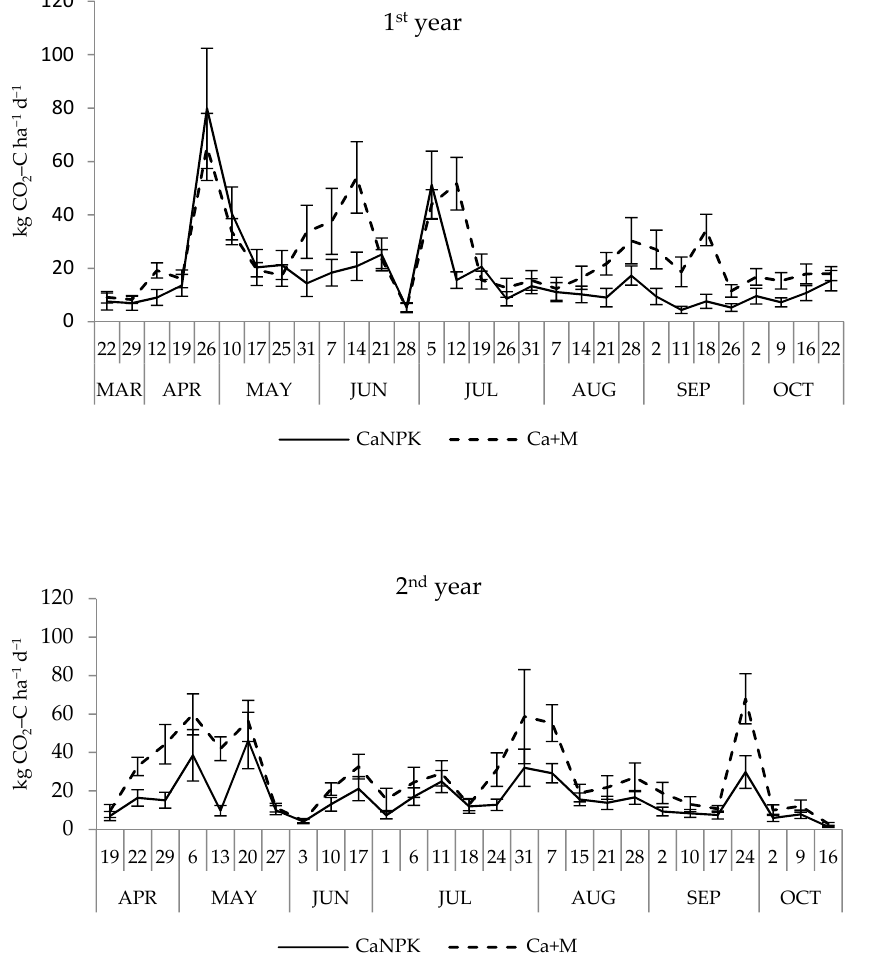
Figure 4. Daily CO 2 –C soil emissions under the CaNPK and Ca + M treatments over the measure- ment period.